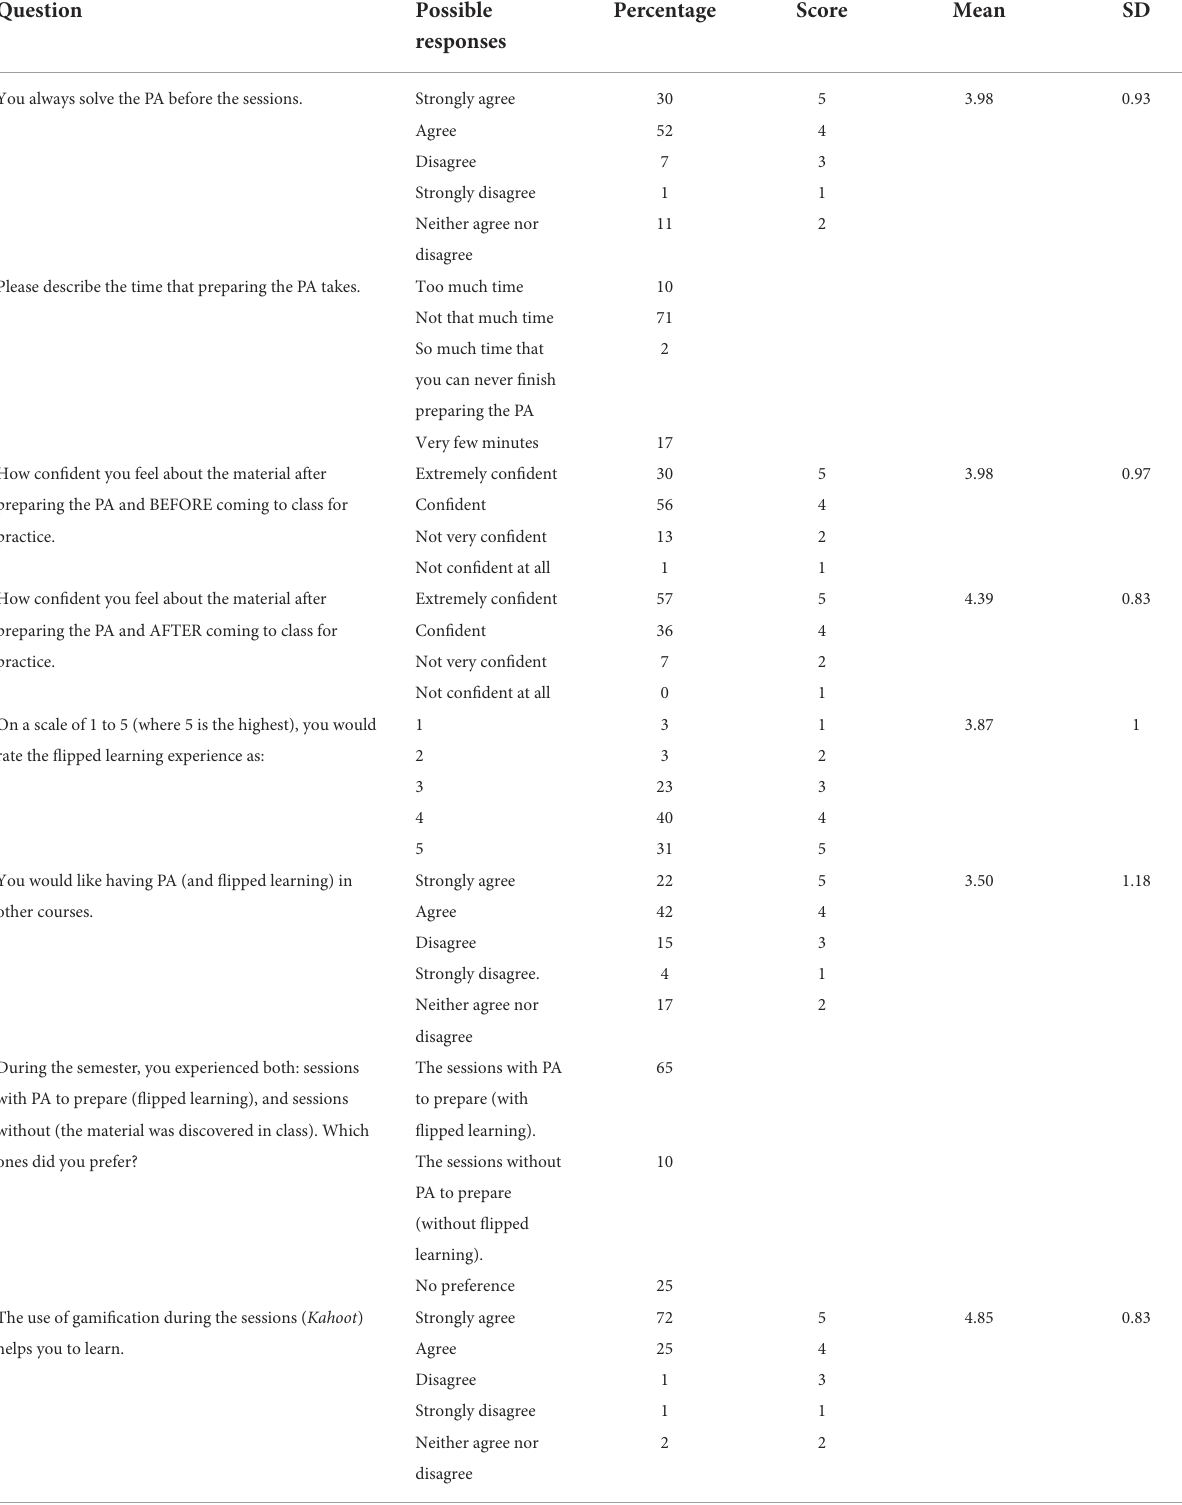
TABLE 4 Student responses to the scaled